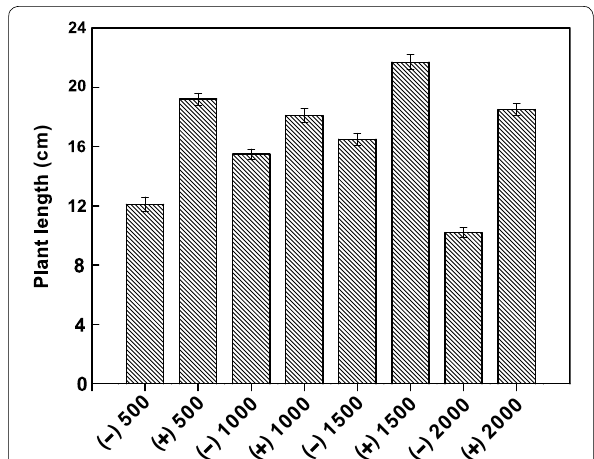
Fig. 7 Lengths of Nepeta cataria during growth in the red soils con‑ taining NH 4 + ‑N. ( ), without Gan‑35; ( ), with Gan‑35. The numbers − + on the horizontal axis are the concentrations of NH 4 + ‑N (mg/kg)